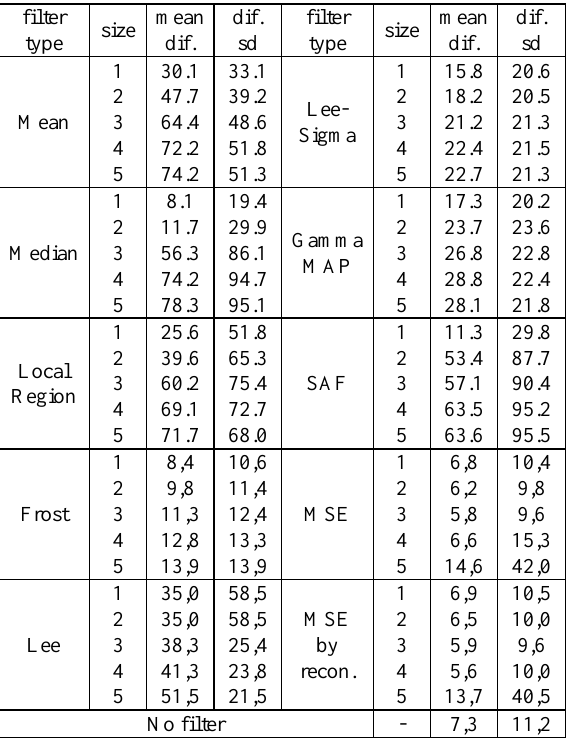
Table 3. Comparison of results of selected filtration of a simulated speckled detailed image to a noise-free reference image; mean dif . is the mean value of the differential image, and dif. sd is its standard deviation value